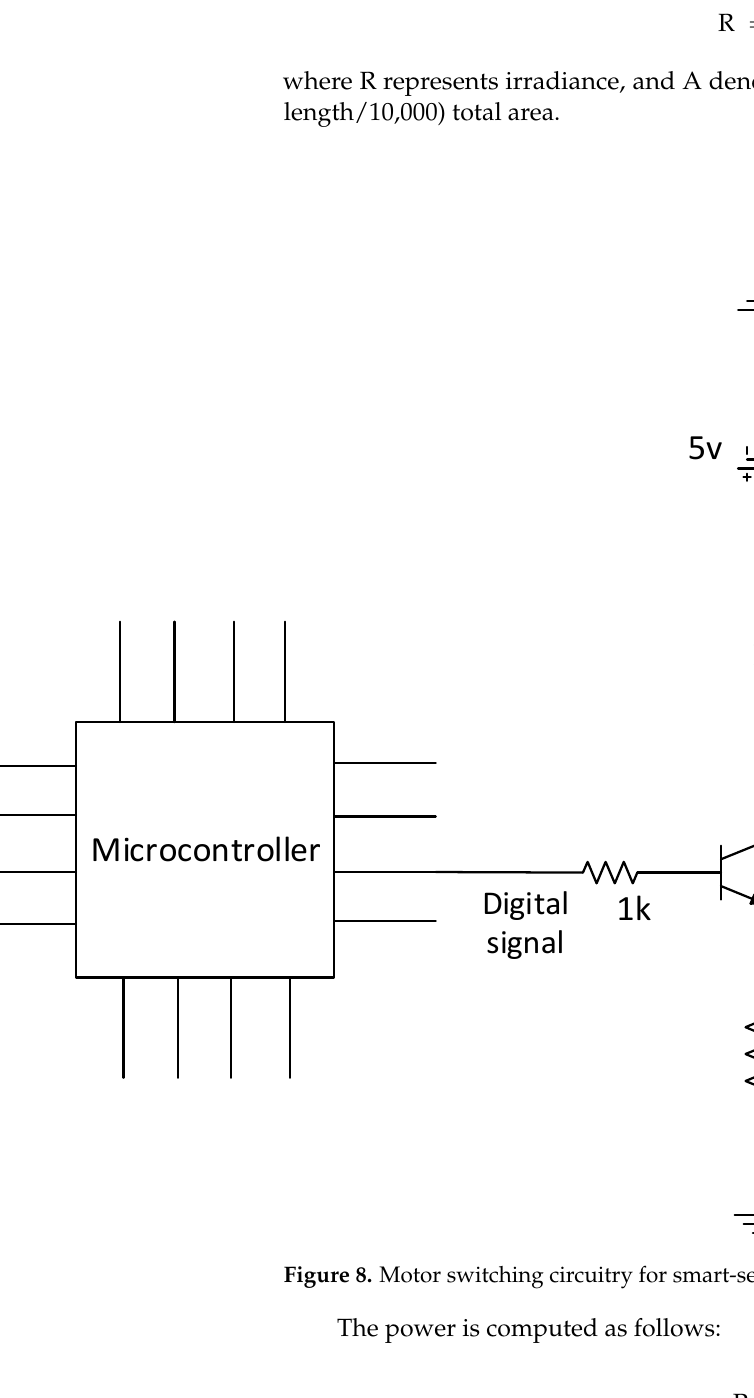
Figure 7. Circuit diagram for irradiance measurement.